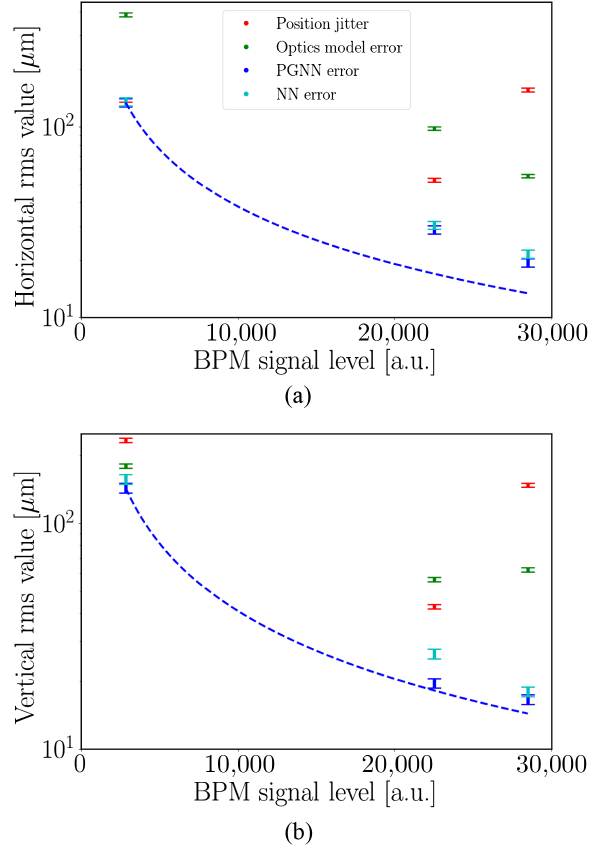
FIG. 13. The data points show the horizontal and vertical rms values for beam jitter and position predictions at BPM 51; the error bars give 95% confidence interval. The resolution scaling from the low charge is given as a dashed line under the assumption that the low-charge results were resolution limited. The NN error denotes the error from a neural network without including predictions from the beamline model.